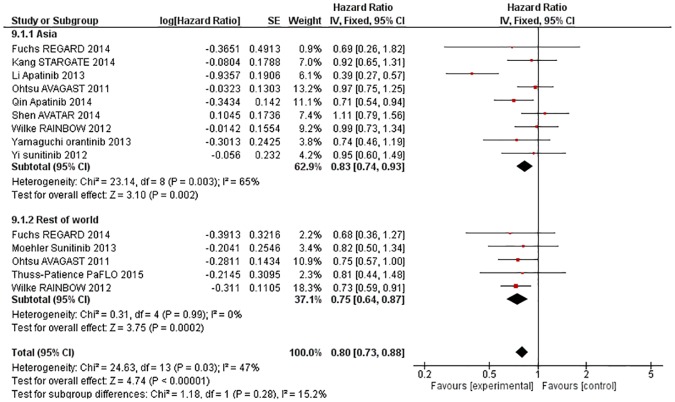
Forest plot—Overall Survival—by region.